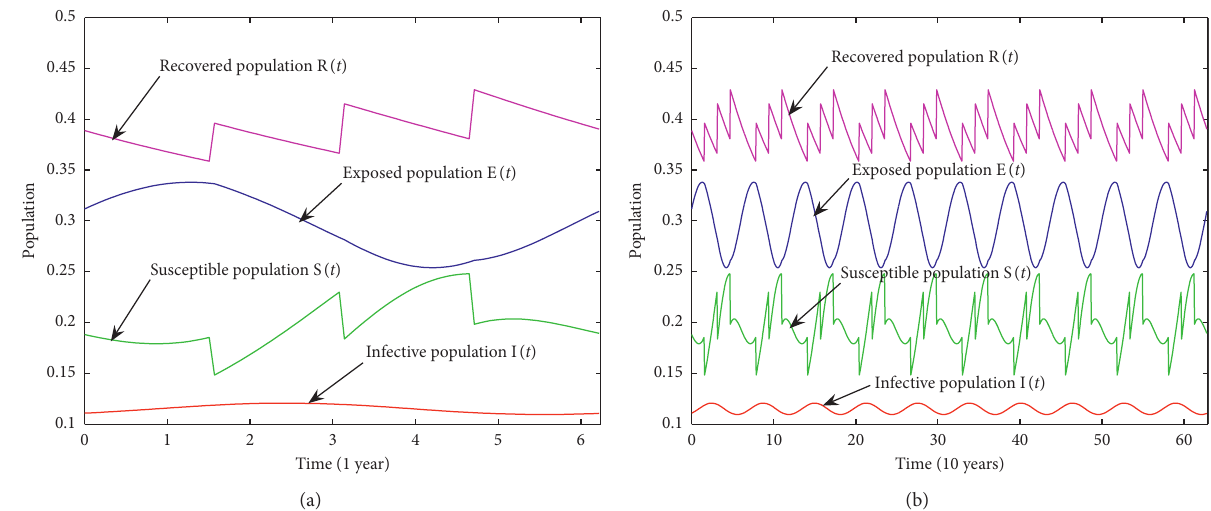
Figure 1: Positive periodic solutions of seasonally forced SEIR with pulse vaccination in 1 year and 10 years.